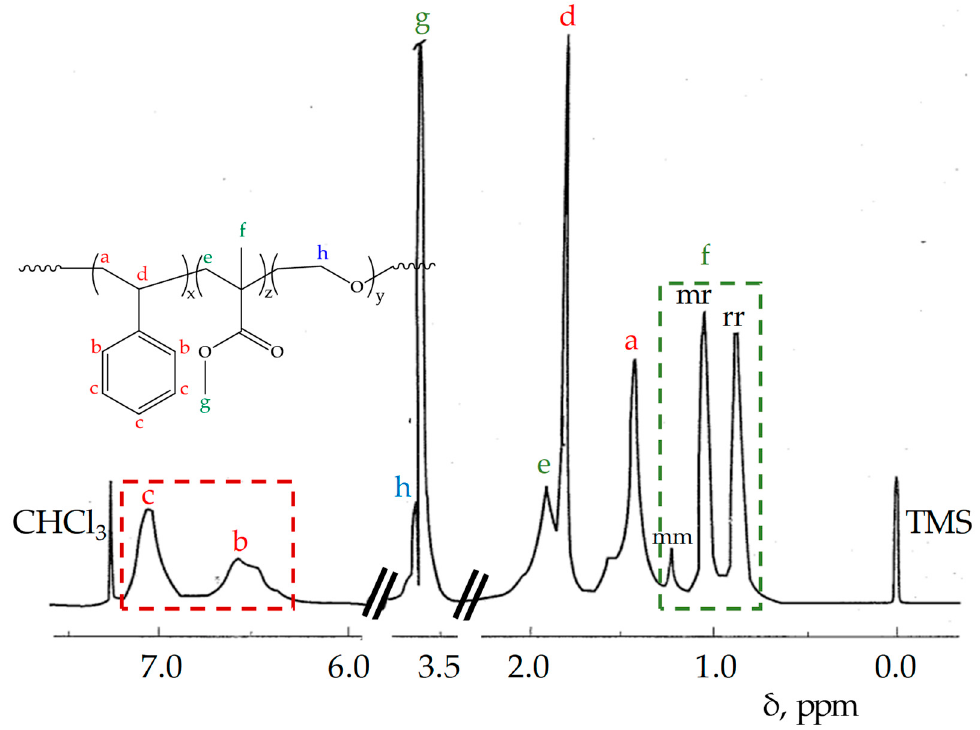
Figure 6. 1 H NMR spectrum of purified copolymer obtained after simultaneous addition of comonomers (STEM 1, Table 1 and Figure 1a,b). The integral intensity of the framed signals (red–aromatic protons, green–backbone methyl protons) and h (backbone methylene protons) was used for copolymer composition estimates (Table 2).